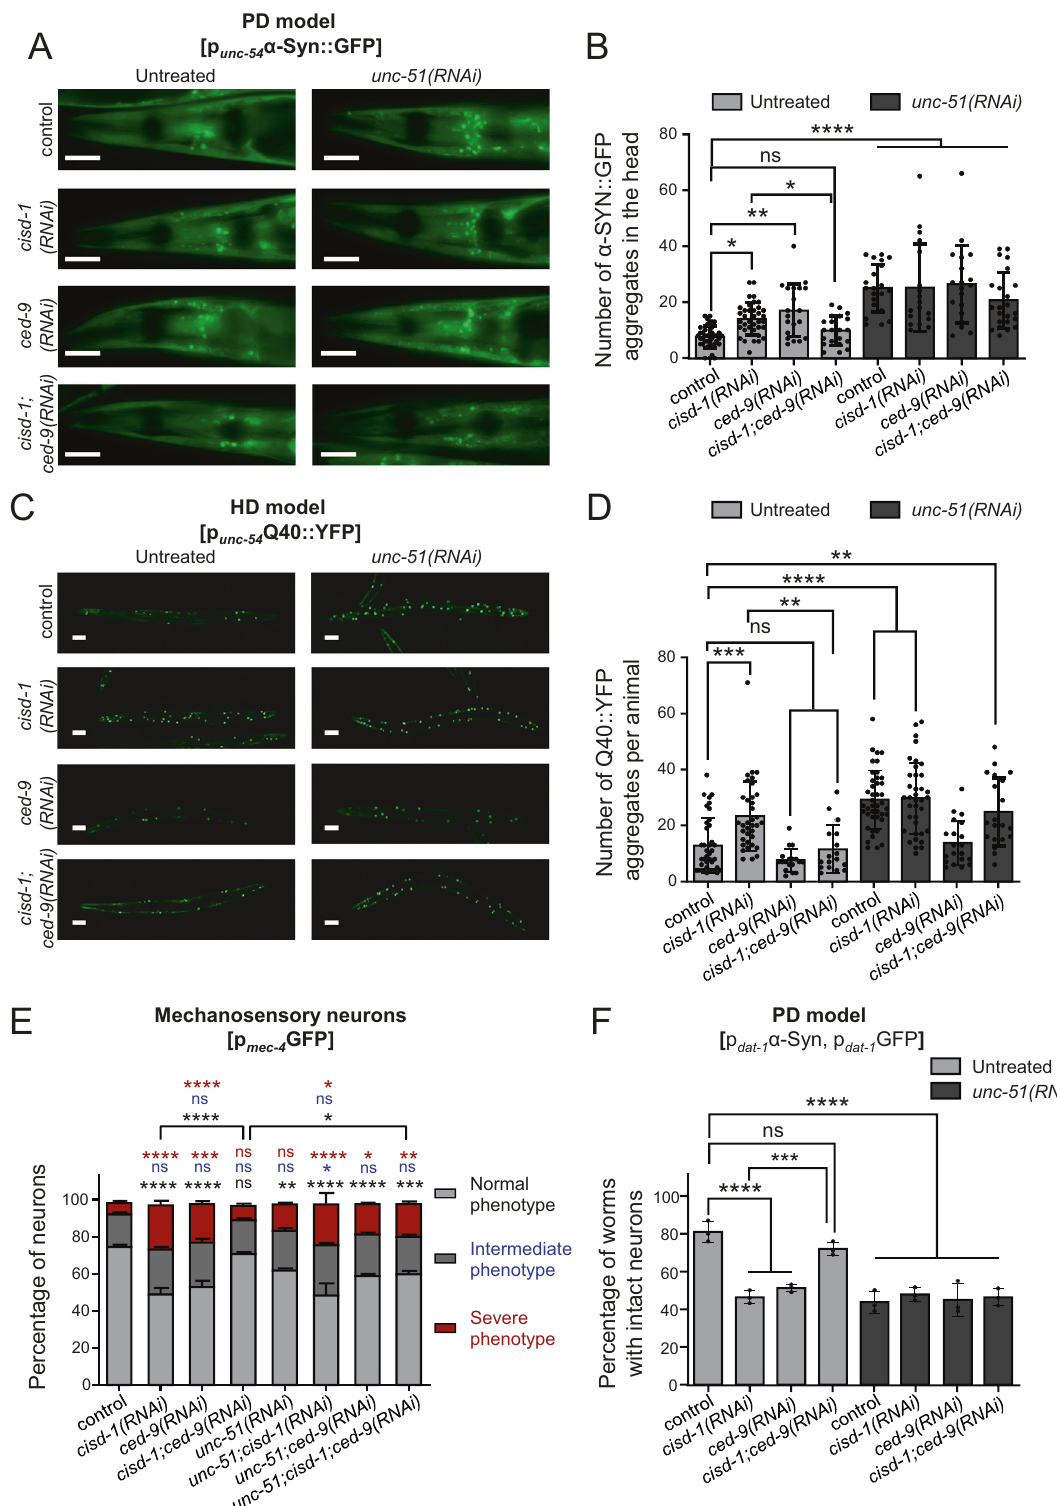
upon mild iron supplementation (10 mM FAC). Combined, these fi ndings indicate that CISD-1 de fi ciency confers resistance to iron supplementation, and that iron modulates the CISD-1- effects on longevity. Iron supplementation does not alter the lifespan of long-lived, CISD-1/CED-9 double de fi cient